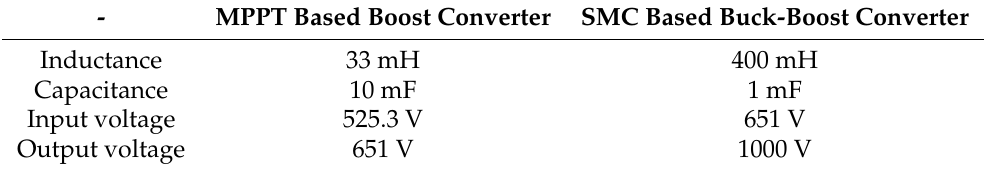
Table 2. DC–DC power converter